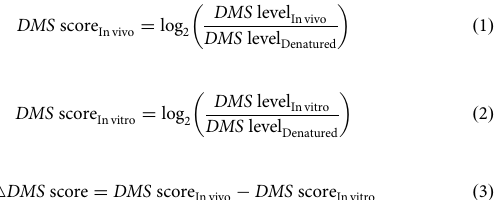
Table 4, we performed site-directed mutagenesis from the plasmids containing RBS WT . The RNA substrates were synthesized with [ 32 P]-UTP by in vitro transcription and puri fi ed by resolving on a denature-PAGE. To prepare N-terminal Histidine-tagged protein, coding sequences of each FUBP3 and PCBP2 were ampli fi ed by speci fi c primers (Supplementary Table 4) and inserted to pET-28b vector. Both recombinant histidine-tagged FUBP3 and PCBP2 proteins were puri fi ed by the HisTrap column (GE healthcare), according to manufacturer ’ s instructions. The GST protein was puri fi ed by the GST af fi nity beads (Elpis Biotech) to be used as a control protein. The puri fi ed recombinant proteins were resolved on 12% SDS-PAGE and stained with Coomassie brilliant blue (BIORAD) (Fig. 7b). Gel mobility-shift assays were performed as previously described 60 . Brie fl y, the reactions were carried out with the following condition: binding buffer (20mM HEPES